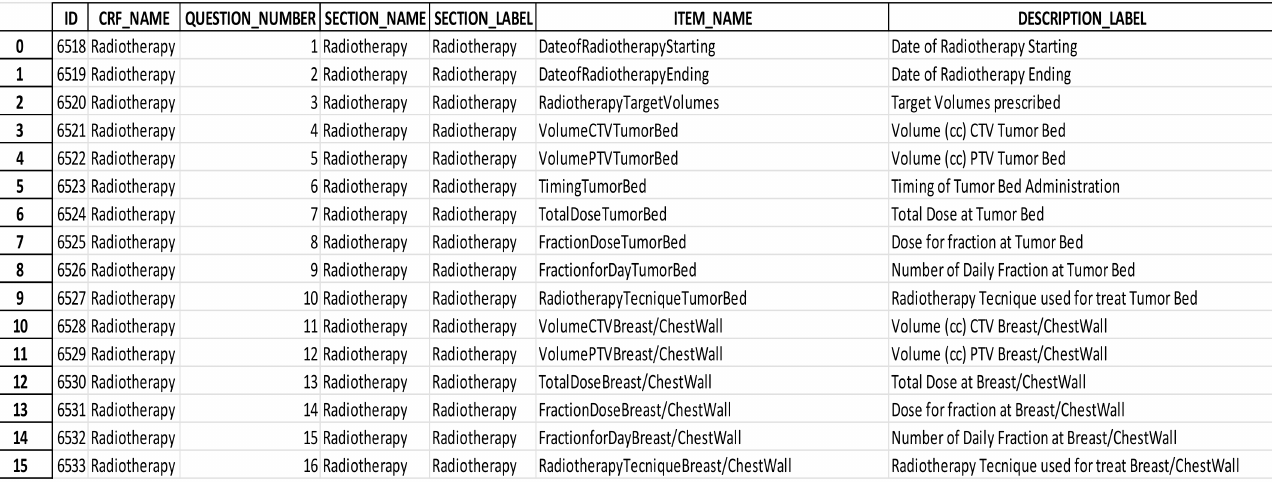
Figure 4. Example of a CRF configuration file. The columns represent various mandatory configuration settings for BOA and are to be interpreted as follows: The ID column represents an internal identifier and is generated automatically when the CRF is first uploaded. CRF_NAME refers to the name by which the CRF is to be visualized in the UI. QUESTION_NUMBER can either be automatically assigned or manually set, and refers to the ordering of the various questions inside the CRF, with SECTION_NAME and SECTION_LABEL working as visual dividers when the questions are displayed in the interface, with the former being the name to be used in the UI code, and the latter being the name to be displayed. ITEM_NAME and DESCRIPTION_LABEL work in a similar manner, with the former being the identifier in the underlying code and the latter being the name of the text to be displayed with the question in the